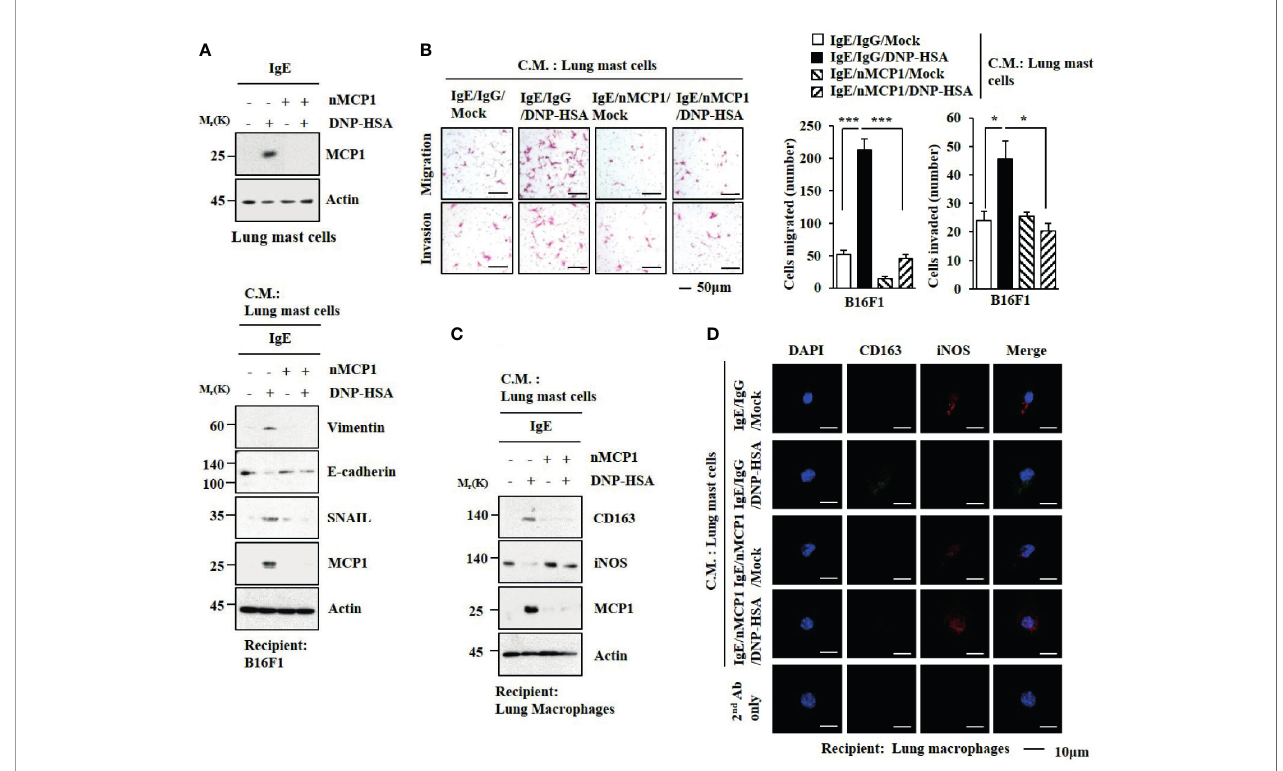
FIGURE 5 | MCP1 is necessary for cellular interactions. (A) Lung mast cells were sensitized with DNP-speci fi c IgE in the presence of the neutralizing MCP1 antibody (nMCP1 Ab) or isotype-matched IgG for 24 h followed by DNP-HSA stimulation for 1 h (upper). The culture medium of lung mast cells was added to B16F1cells for 24 h followed by immunoblot (lower). C.M. denotes culture medium. Representative blots of three independent experiments are shown. (B) Culture medium of lung mast cells was added to B16F1 cells for 48 h. Invasion and migration potentials of B16F1 cells were determined. * p <0.05; *** p <0.001. (C) Same as (A) except that culture medium was added to lung macrophages. Representative blots of three independent experiments are shown. (D) Immuno fl uorescence staining was